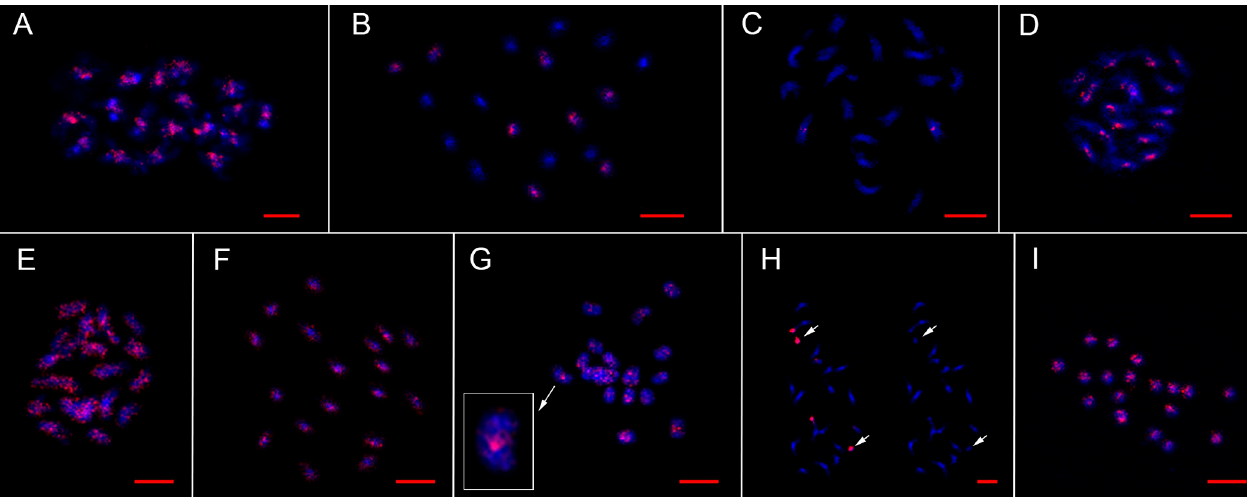
Fig 4. Chromosomal distribution of eight satDNA families. (A) FISH with the f1 probe on chromosomes of C . acuminatum . (B) FISH with the f2 probe on chromosomes of C . acuminatum . (C) FISH with the f3 probe on chromosomes of C . suecicum . (D) FISH with the f4 probe on chromosomes of C . suecicum . (E) FISH with the f5 probe on chromosomes of C . suecicum . (F) FISH with the f6 probe on chromosomes of C . acuminatum . (G) FISH with the f7 probe on chromosomes of C . acuminatum . An enlarged chromosome with a clear centromeric signal is shown in a separate box. (H) FISH with the f8 probe on chromosomes of C . iljinii . A metaphase plate with a red signal from the f8 satDNA family is shown on the left, and DAPI staining of the same metaphase plate is shown on the right. The smallest pair of chromosomes with major blocks is indicated by arrows. (I) FISH with an MS probe on chromosomes of C . acuminatum . All chromosomes were counterstained with DAPI. Bars represent 5 μ